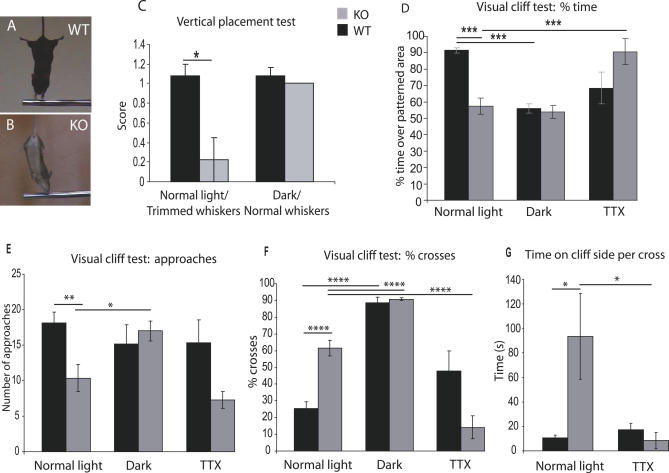
Ten_m3 KO Mice Show Deficits in the Performance of Visually-Mediated Behavioural Tasks(A–C) Vertical placement test. Examples of responses by a typical WT mouse ([A]: score of 1) and KO mouse ([B]: score of 0) are shown. WT mice scored significantly better (1.1 ± 0.11; n = 10) than KOs (0.22 ± 0.22; n = 9; p < 0.5, t-test) on this task under normal light conditions with trimmed whiskers. The ability of KO mice to perform this test using their somatosensory systems was tested by performing the test under red light (a wavelength not detected by mouse retina) with whiskers at normal length. KO and WTs performed the test equally well under these conditions. Mean scores ± s.e.m. are plotted in (C).(D–G) Results of visual cliff test (see also Videos S1, S2, and S3). (D) Total time spent in the patterned half of the box. Under normal light, WTs spent over 90% of their time in the patterned region, whereas KOs spent only half their time in this region. Under red light (dark conditions), WTs spent around half their time on each side of the cliff. There was no change in the time the KOs spent on each side of the cliff under red light. Following acute inactivation of one eye with TTX, the performance of the WT mice deteriorated, although this was not significant (p > 0.05, t-test). The TTX-treated KOs spent almost all their time on the patterned side of the box, similar to WTs under the control condition. (E–G) Visual cliff data analysed for number of approaches to the midline (E) and the percentage of approaches for which the mice crossed the midline (F) and time spent on the cliff side per cross (G). KOs approached the midline significantly less often than WTs under normal light conditions. Both groups made similar numbers of approaches to each under dark conditions. KOs made significantly more approaches in dark conditions compared to KOs under ambient light. The number of approaches made by WTs and KOs with monocular activation is similar to the number made by each group under normal light (E). Under normal light, the percent of crossings made by KOs is significantly greater than for WTs. Both groups crossed the border a significantly higher percentage of time under darkness than under normal light. The percentage of crossings is higher for WTs with TTX than for WTs under normal light conditions, though this is not significant. KOs with TTX, however, crossed the border significantly less often than KOs under normal light (F). The amount of time spent on the cliff side per cross is significantly higher for KOs under normal light conditions than for WTs under any condition or for KOs with TTX (G). A single asterisk (*) indicates p < 0.05; double asterisks (**) indicate p < 0.01; triple asterisks (***) indicate p < 0.001; and quadruple asterisks (****) indicate p < 0.0001.